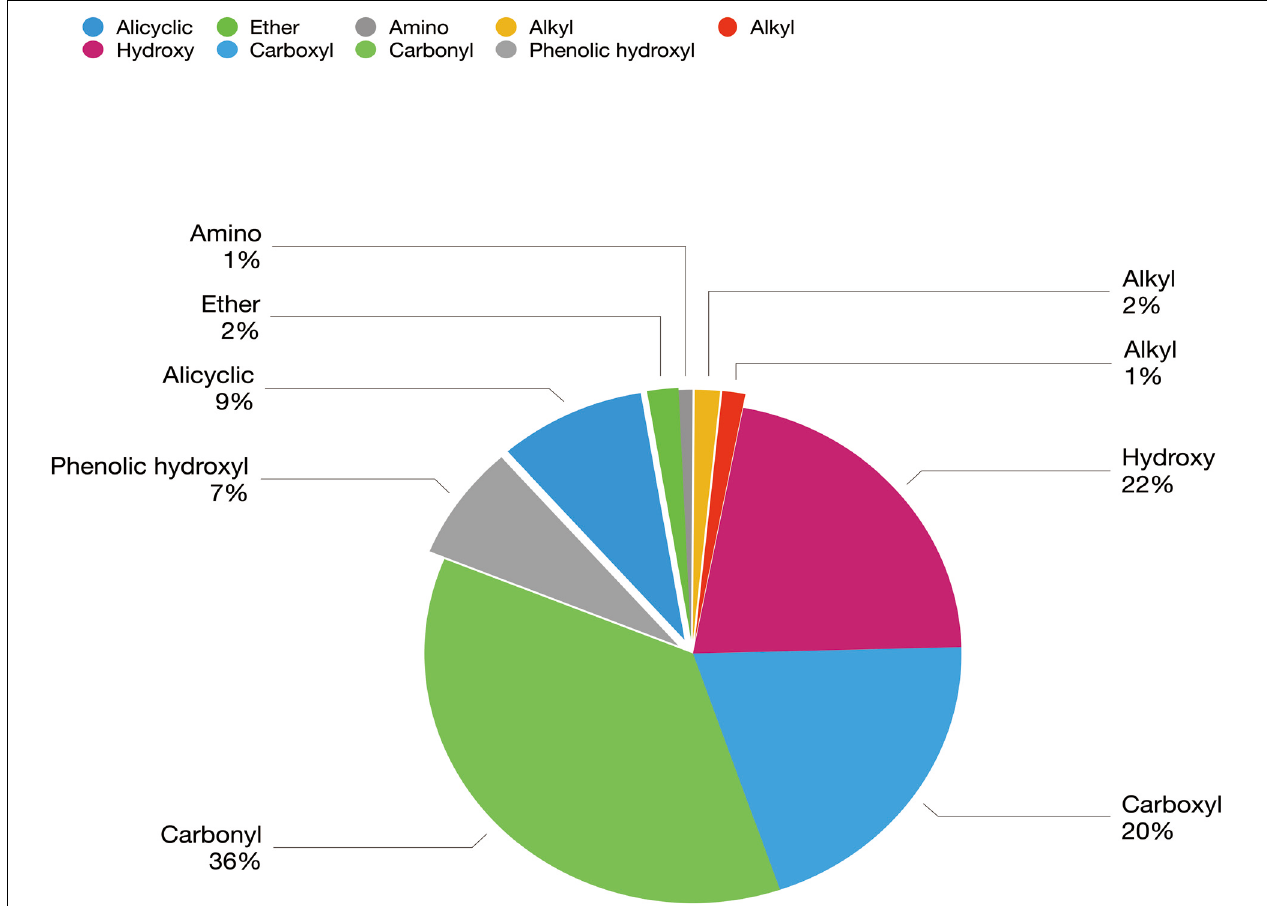
FIGURE 3 | Composition and concentration of functional groups in the organic molecules from biochar-extraction